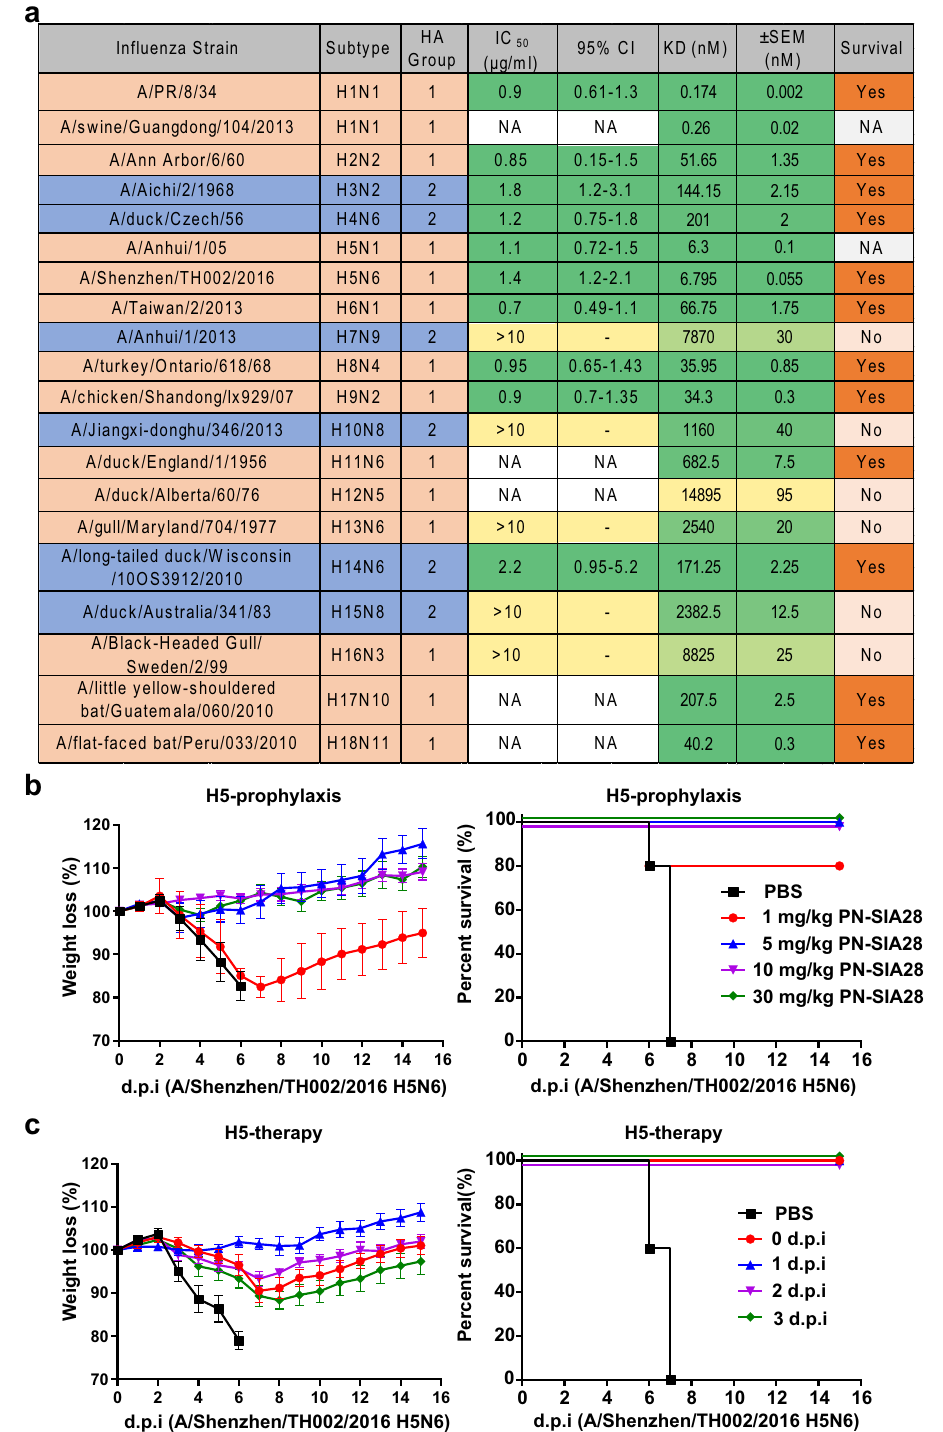
Fig. 1 | Broad reactivityand potentprotectiveeffect ofPN-SIA28.a Binding and neutralizingactivityofPN-SIA28.BindingkineticsweremeasuredbyBLI,andtheK D values shown are the mean±SEM of two independent experiments. IC 50 , half- maximal inhibitory concentration; CI, con fi dence interval; NA, not available; sur- vival, binding by gel fi ltration chromatography. Detailed binding properties of different HA proteins with PN-SIA28 are shown in Supplementary Fig. 2. b Prophy- lactic ef fi cacy of PN-SIA28 against a lethal challenge with the A/Shenzhen/TH002/ 2016 (H5N6) virus. Shown are weight loss (left) and survival curves (right) of mice treated with 30, 10, 5, or 1mg/kg of PN-SIA28 or PBS buffer 24h before lethal